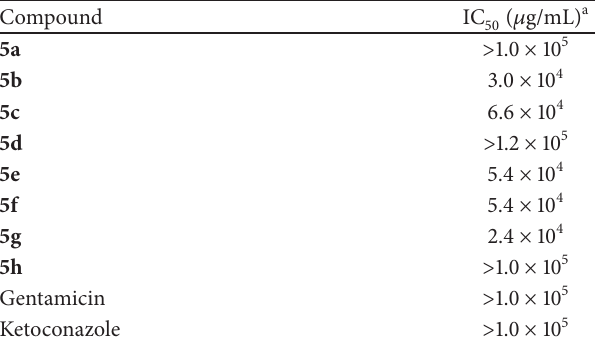
Table 3: In vitro cytotoxicity of compounds (5a–h) on noncancer cell line